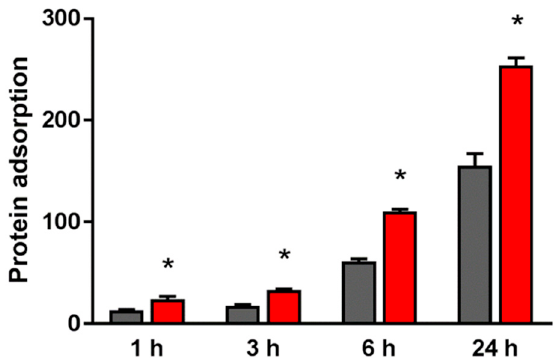
Figure 2. The adsorption amount of BSA on the material surface of the test group (red) and that of the control group (black). * p < 0.05.